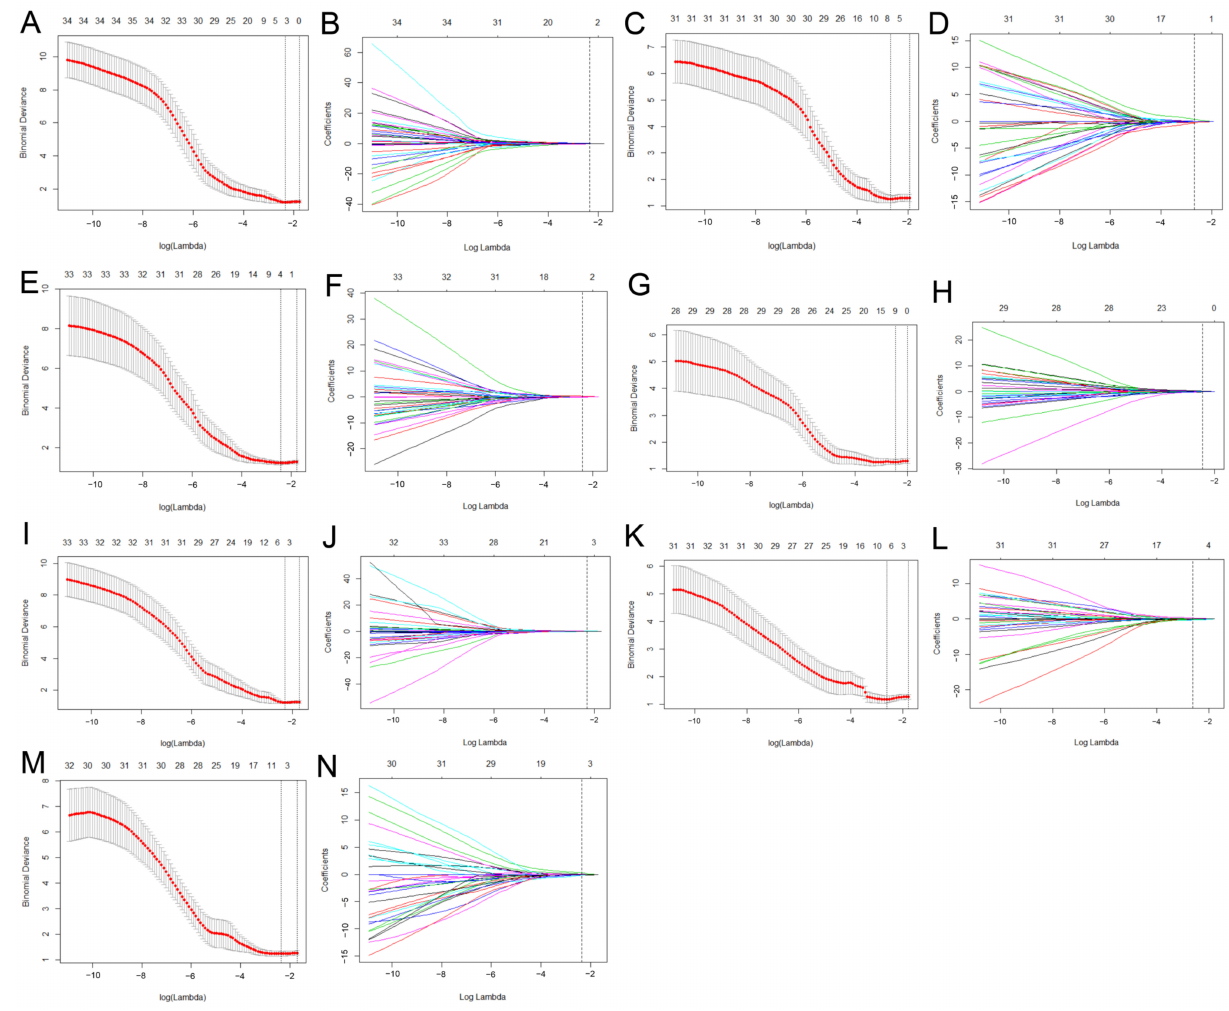
Figure 3. Feature selection using LASSO logistic regression of T2WI ( A , B ), AP ( C , D ), PVP ( E , F ), T2WI + AP ( G , H ), T2WI + PVP ( I , J ), AP + PVP ( K , L ), and T2WI + AP + PVP ( M , N ) imaging. The LASSO binary logistic regression model was used to select features and the regularisation parameter ( λ ) of the LASSO was used to perform 10-fold cross-validation ( A , C , E , G , I , K , M ). The coefficients were plotted against the log ( λ ) sequence, and the vertical line was drawn at the value selected using 10-fold cross-validation in the ln(lamda) sequence, nonzero coefficients were selected finally ( B , D , F , H , J , L , N ). LASSO, least absolute shrinkage and selection